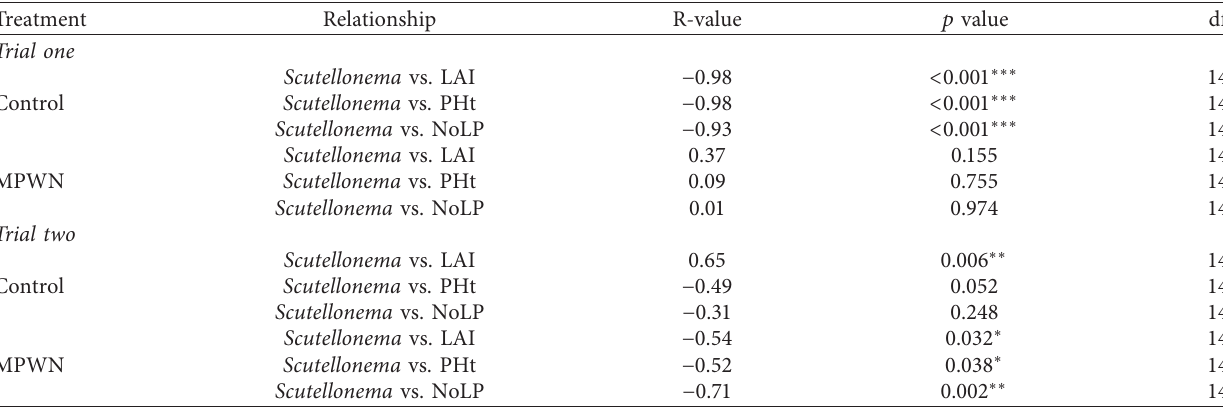
Table 4: Relationship between Scutellonema abundance, maize leaf area index (LAI), plant height (PHt), and number of leaves per plant (NoLP) in control plots (treated with nematicide) and MPWN (maize plots with no nematicide) during trial one (2018) and two (2019) at Nyangati study site, Mwea subcounty.